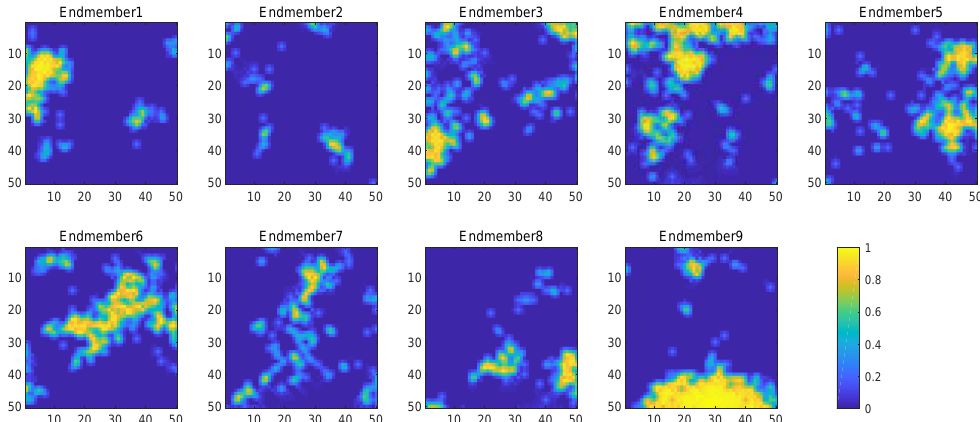
Figure 1. Ground-truth abundance maps associated to nine endmembers used in S 2